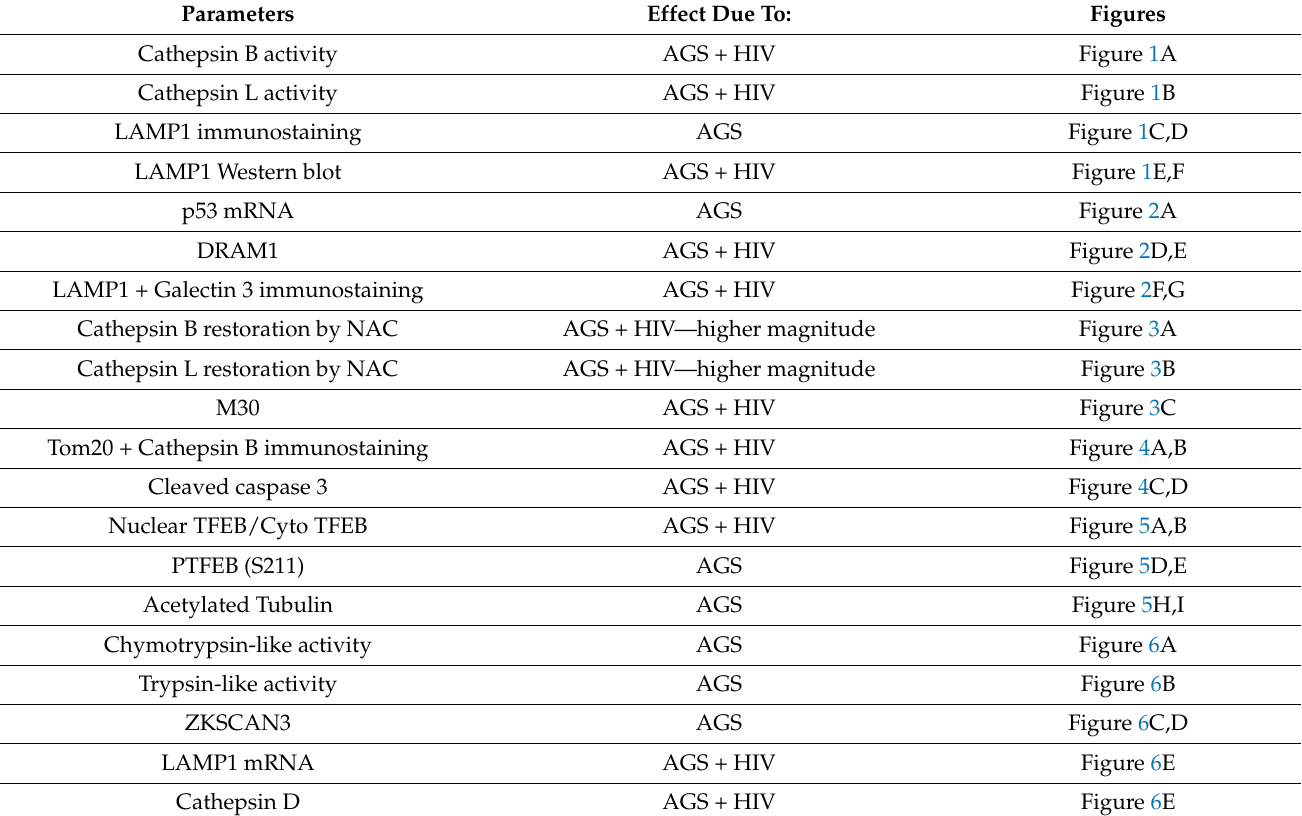
Table 1. Endpoints of the current study regulated by AGS only or by the combination of AGS/ethanol with HIV.